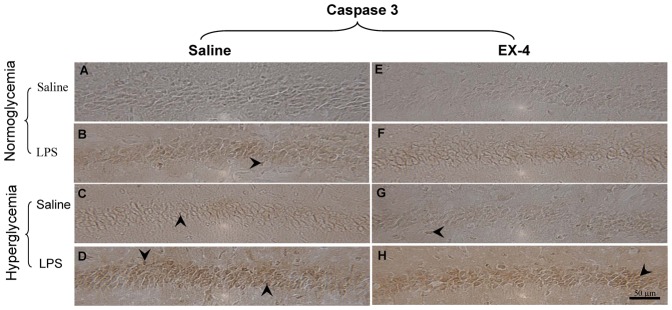
Immunohistochemical analysis of apoptosis in the mouse hippocampus.(A–H) Representative immunostainings of caspase 3 are shown in the CA1 subregion of the hippocampus. Scale bar = 50 µm. Arrowheads indicate positive staining signals (n = 3–5 per group).